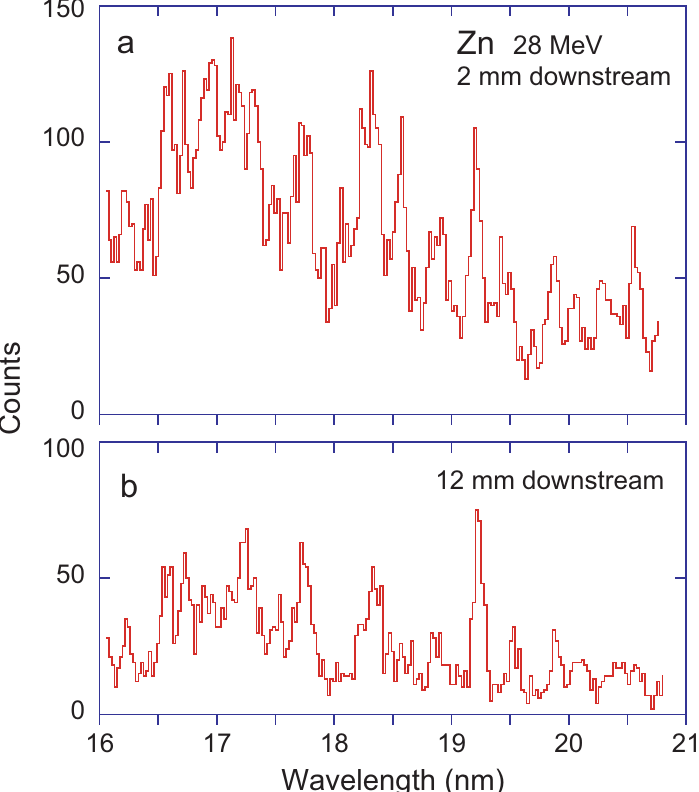
Figure 29. Beam-foil spectra of Zn at an ion beam energy of 28 MeV. Line width (FWHM) 0.09nm. Observation with a delay after excitation of ( a ) about 200ps; ( b ) about